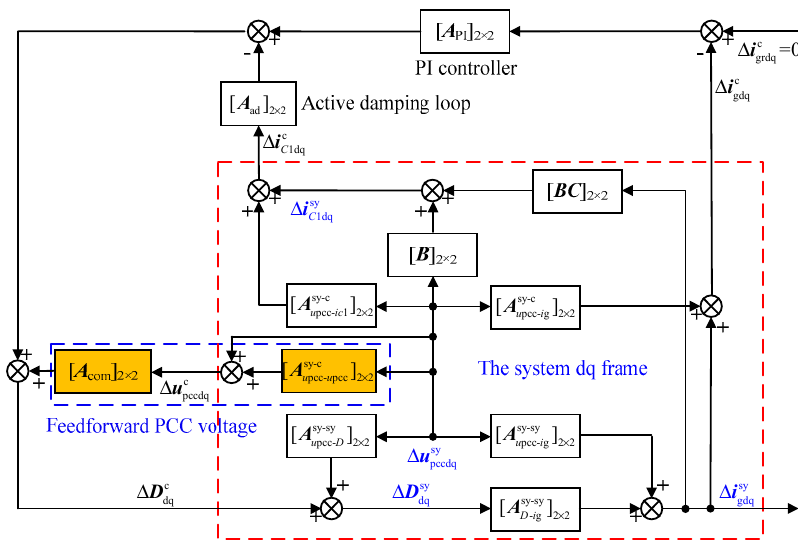
Figure 9. The dq admittance model of proposed admittance reshaping technique 1.